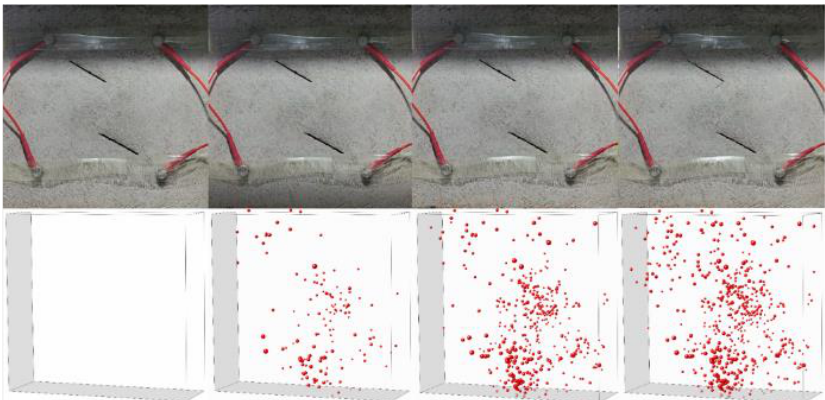
Figure 11. 90-5-1 specimen surface macrocrack and acoustic emission crack location information map.